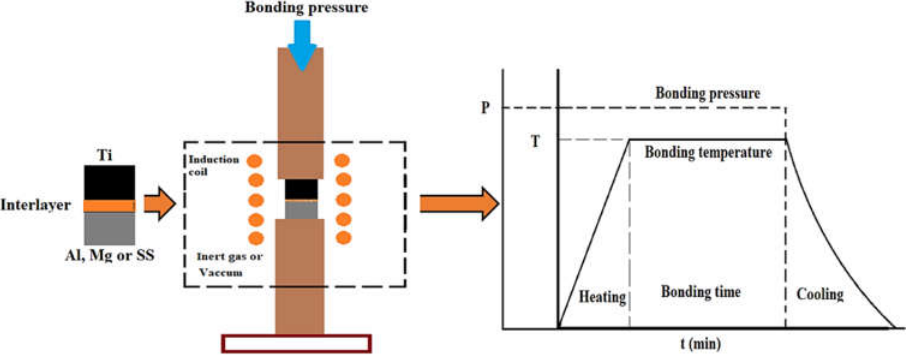
Figure 2. Schematic of the diffusion bonding process and the process parameters (Al—aluminium, Mg—magnesium, and SS—stainless steel).